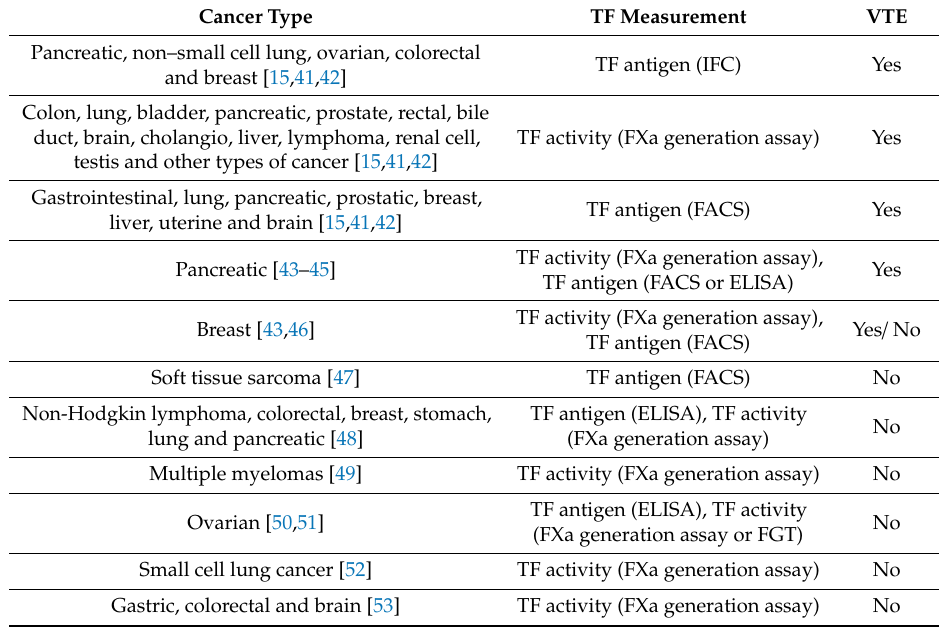
Clinical studies associating tissue factor (TF)-containing extracellular vesicles and venous thromboembolism. Cancer Type TF Measurement VTE Pancreatic, non–small cell lung, ovarian, colorectal TF antigen (IFC) Yes and breast [15,41,42] Colon, lung, bladder, pancreatic, prostate, rectal, bile duct, brain, cholangio, liver, lymphoma, renal cell, testis and other types of cancer [15,41,42] Gastrointestinal, lung, pancreatic, prostatic, breast, liver, uterine and brain